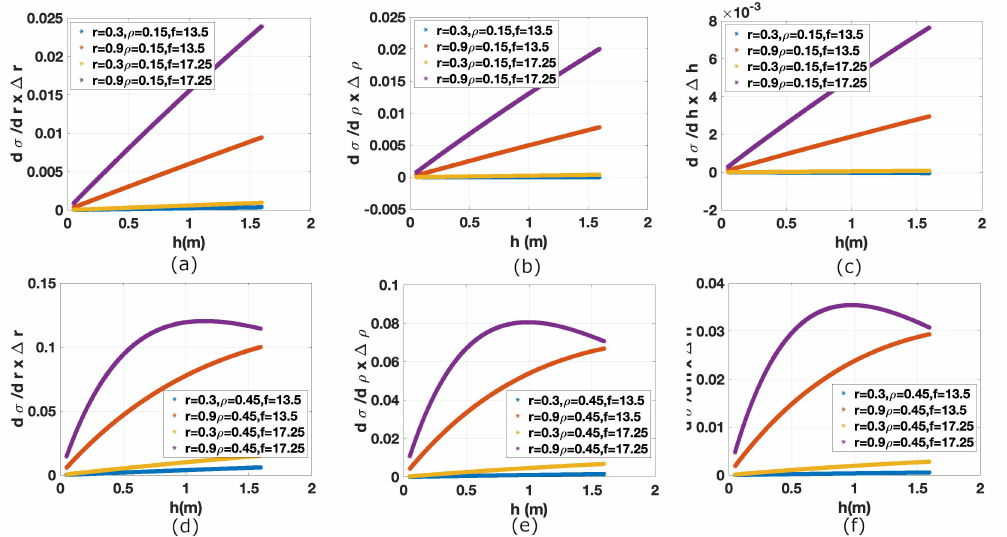
Figure 7. Normalized backscattered power variation vs. snow depth for 20% change in ( a , d ) snow grain radius, ( b , e ) snow density, ( c , f ) snow depth. Top and bottom plots show the results for snow density of 0.15 and 0.45 g/cm 3 ,